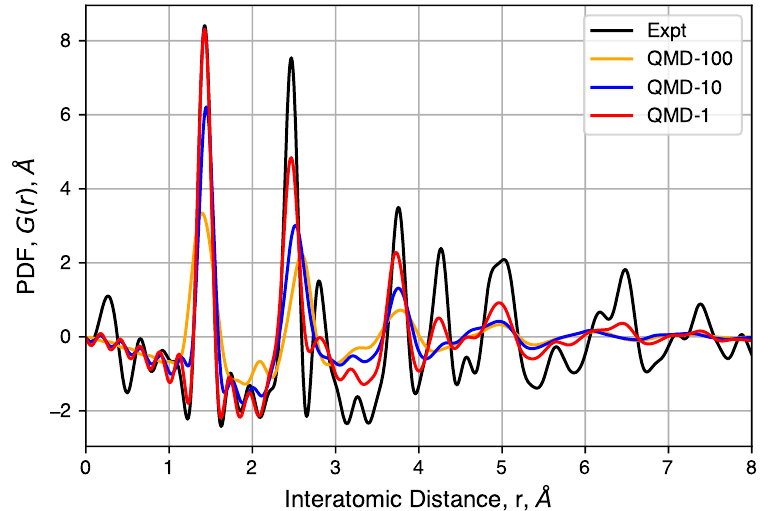
Figure 8. Experimental and simulated pair distributed functions (PDFs) for three QMD-generated structures. Corrections used in the DISCUS software result in some noise in the region of r < 1 nm, whereas a corresponding radial distribution function (RDF) would have only zero